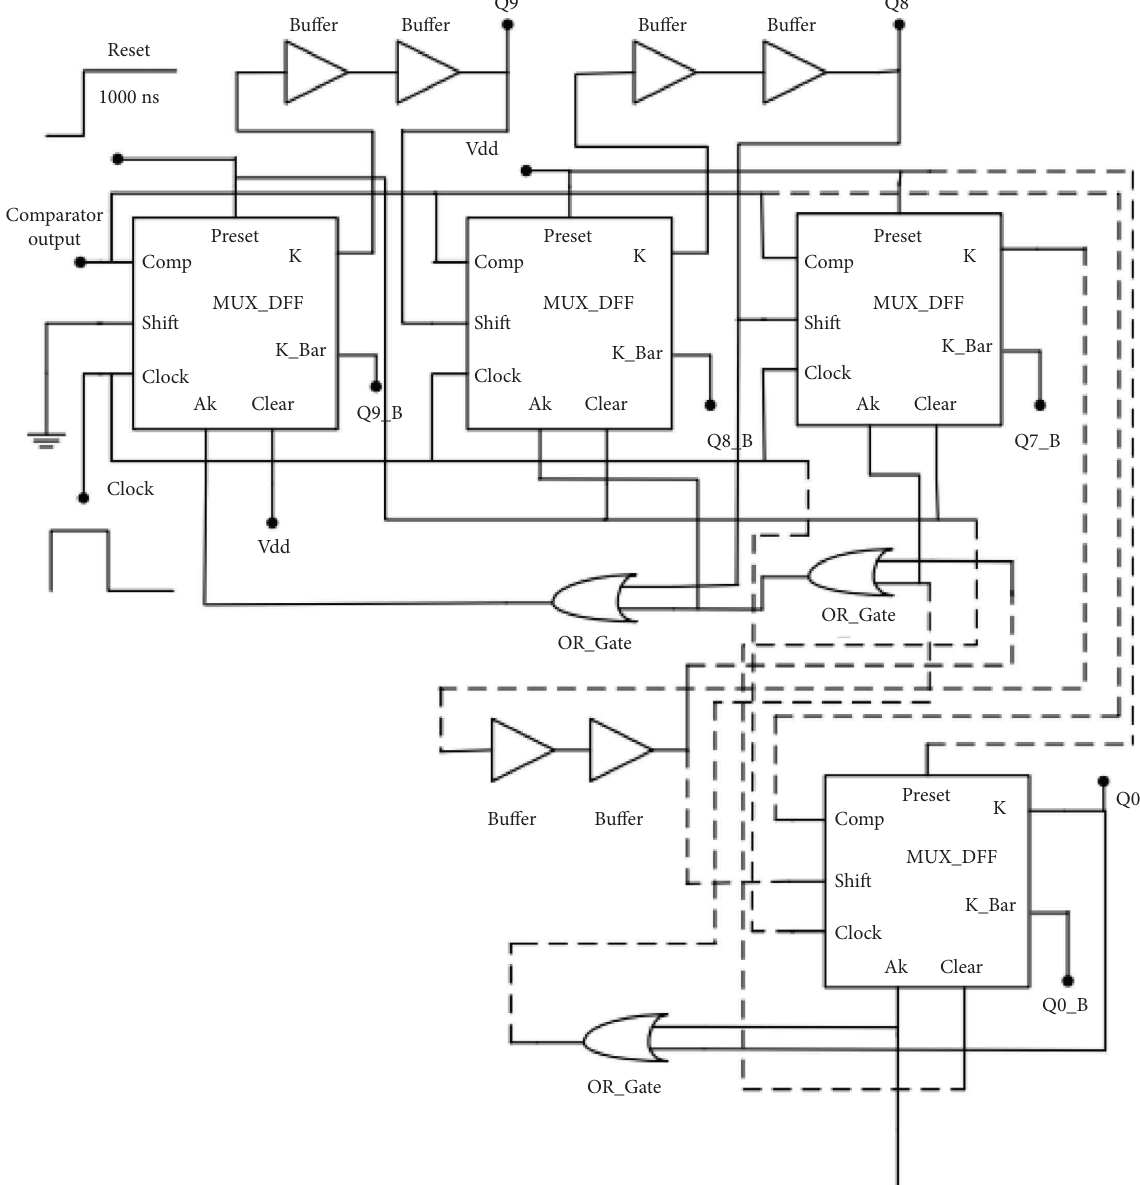
Figure 37: Schematic of the nonredundant register SAR logic